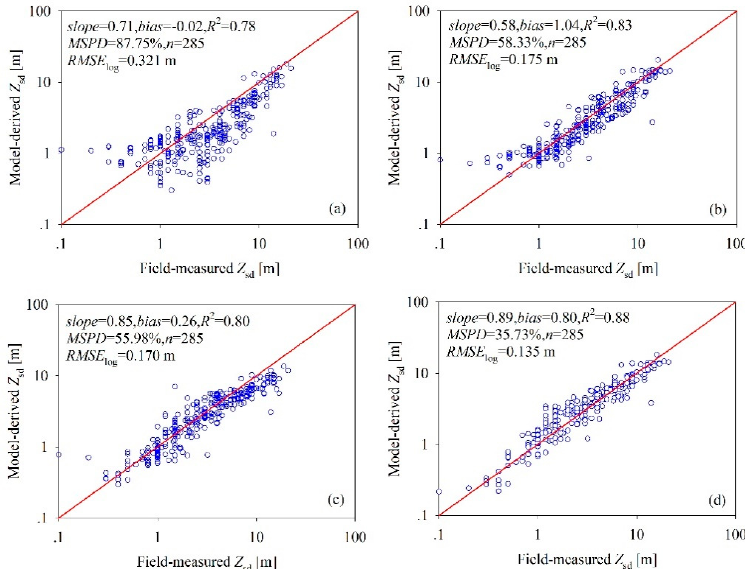
Figure 3. Scatterplots of field-measured against ( a ) BGSD, ( b ) IOPSD, ( c ) MKSD, and ( d ) CSSD models-derived Z sd for the test dataset in Table